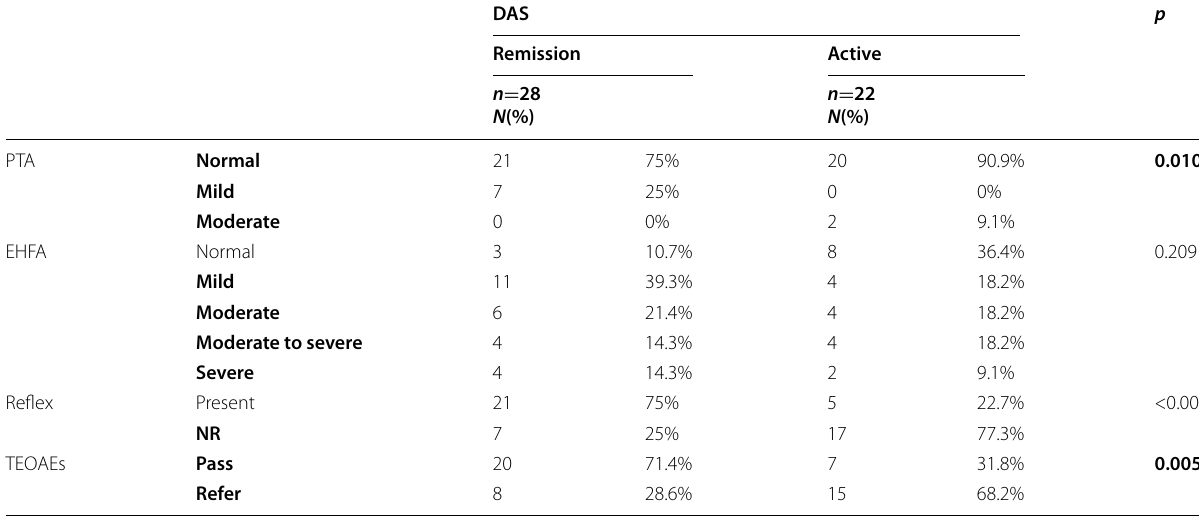
Table 4 Correlation between audiological parameters and